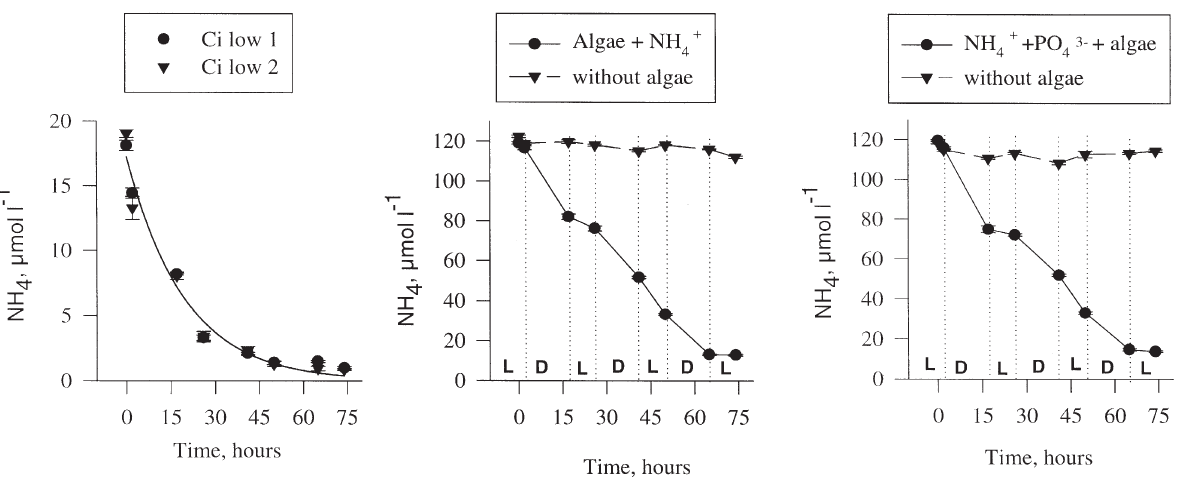
Vertical bars are standard errors.